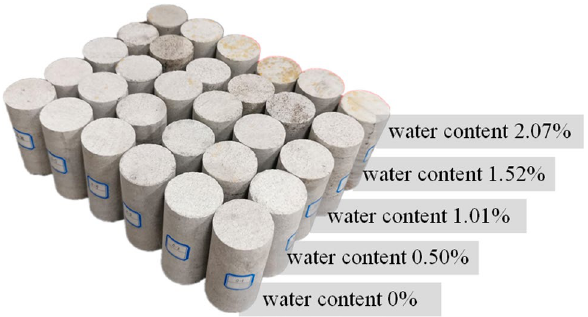
Fig. 3 Sandstone samples with different water